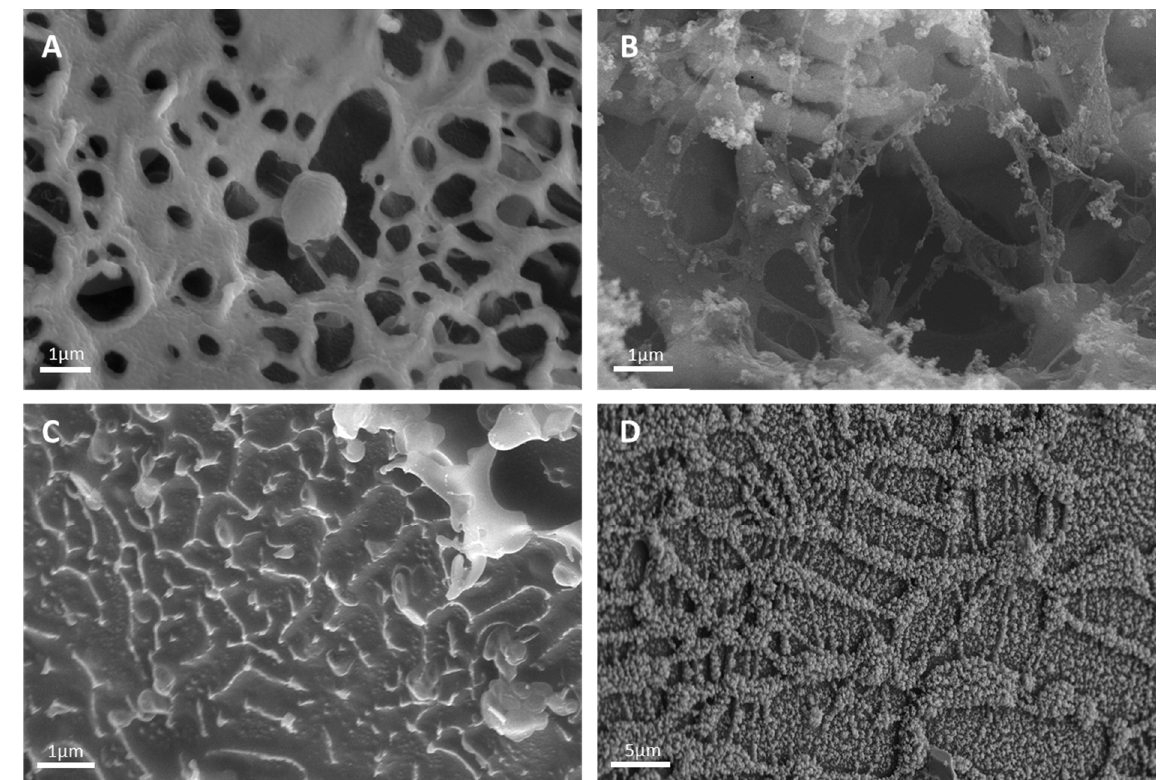
Figure 4. Representative SEM micrographs of freeze fractures that show the microstructure of the mucin network of UWS from a healthy volunteer ( A ), from a patient that received eight radiotherapy fractions ( B ), from a patient that received 28 radiotherapy fractions ( C ) and HA 0.25% ( w / w ) ( D ).